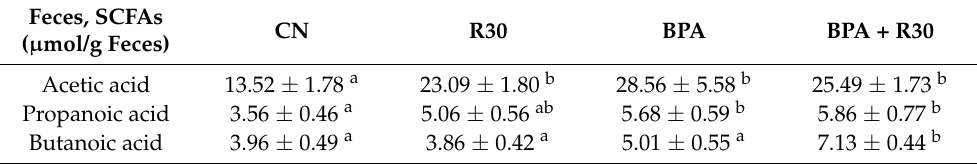
Table 2. Short-chain fatty acid (SCFA) concentrations in feces of male offspring rats. Feces,